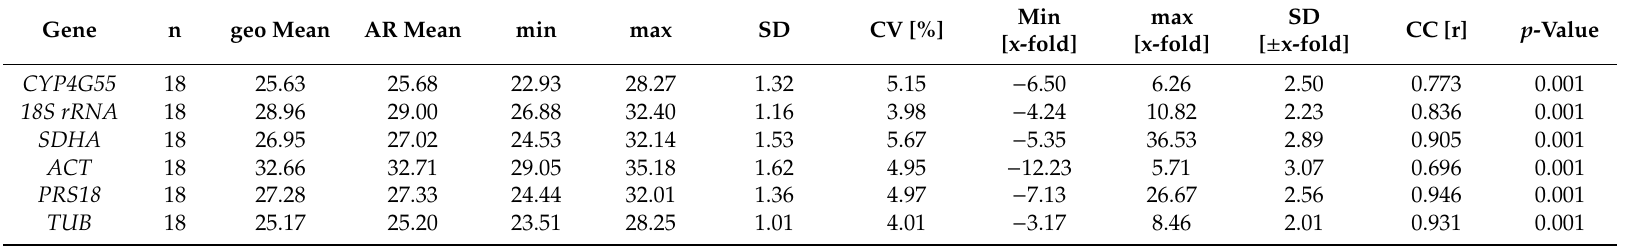
Table 3. Expression stability of the candidate reference genes in mature larval D. valens evaluated using BestKeeper.